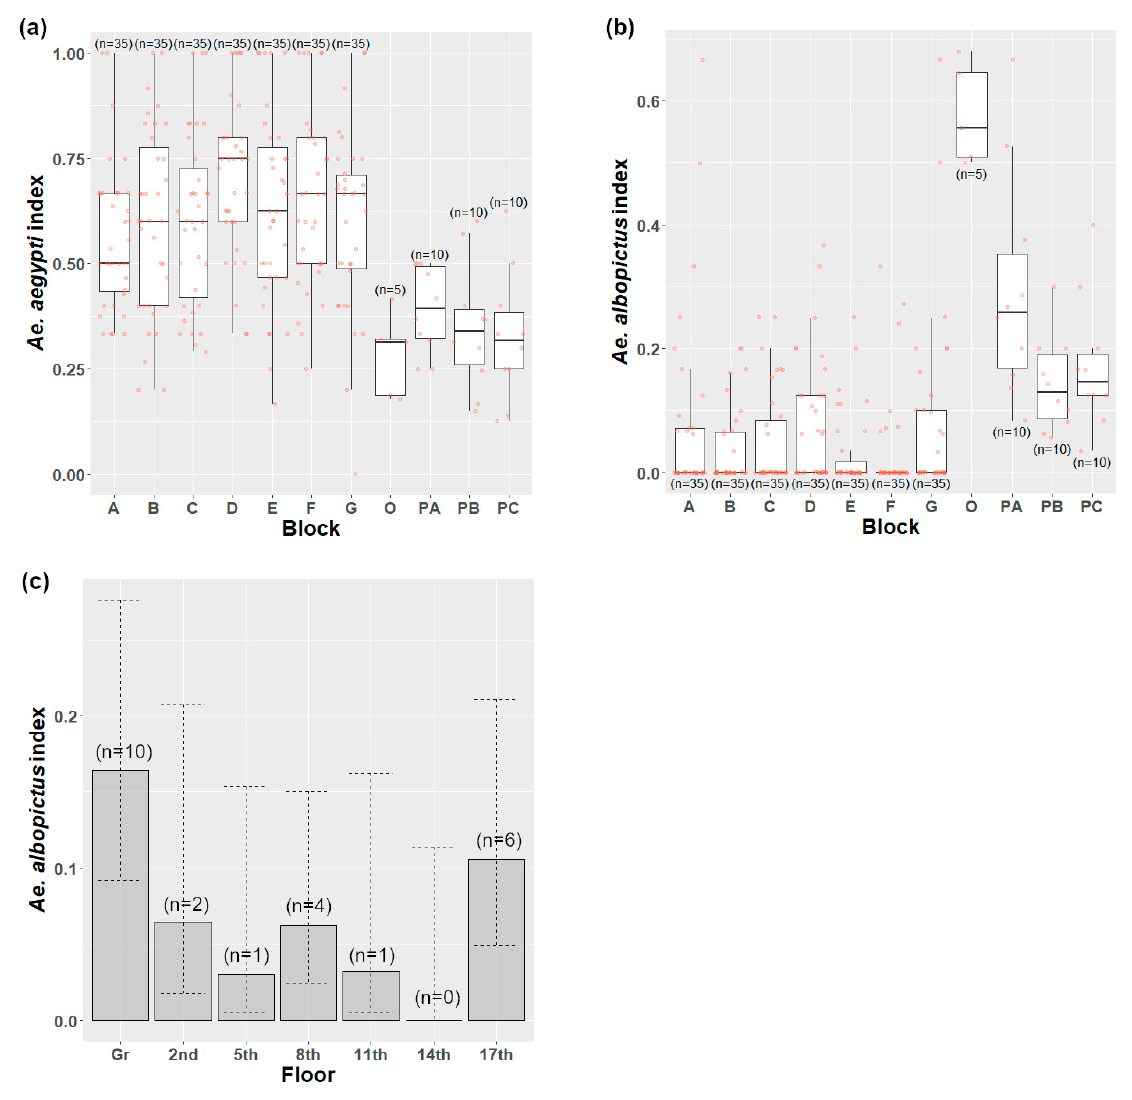
Figure 5. ( a ) Ae. aegypti index by blocks; ( b ) Ae. albopictus index by blocks; ( c ) Ae. albopictus index by floors in Mentari Court from 17 October 2017 to 2021.